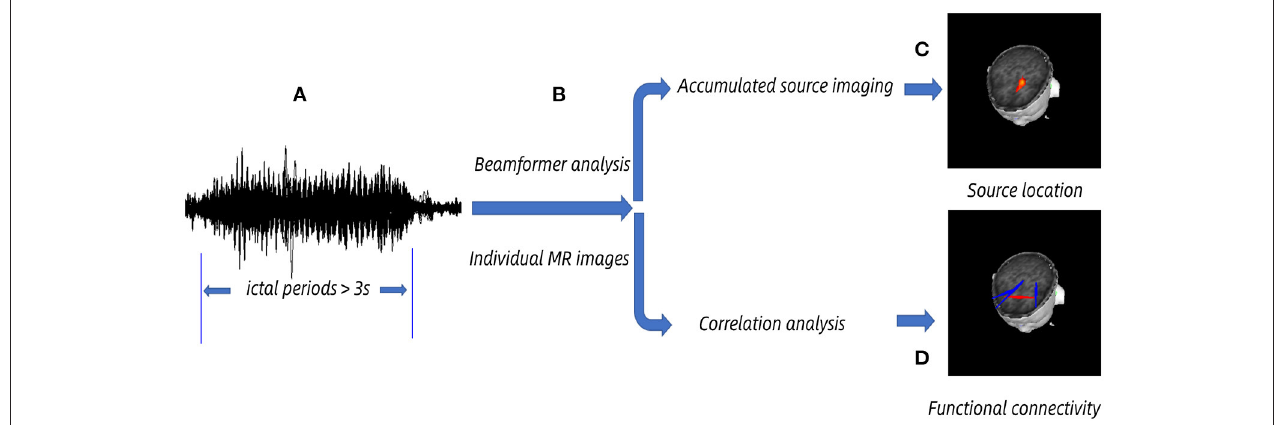
FIGURE 1 | Schematic diagram of magnetoencephalography (MEG) data analysis. MEG data were acquired, and we chose > 3s ictal periods for analysis. (A) Ictal periods. (B) The beam-former was applied to cast sensor-level signals to the anatomical brain regions according to individual MR images at the source level. (C) Accumulated source imaging was generated by spatially overlying the source MEG data and exhibiting the predominant source location. (D) Functional connectivity network was obtained by correlation analysis, and the significant network was acquired at a predefined